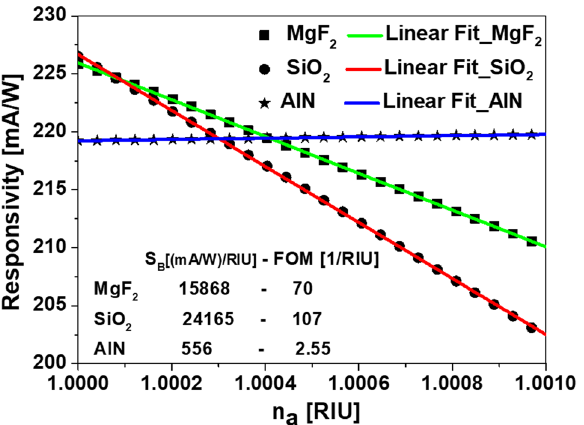
Figure 5. Responsivity, R , as a function of the refractive index of the analyte, n a , for the device with the optimized geometry of the bow-tie made of MgF 2 (black squares), SiO 2 (black circles), and AlN (black stars). The linear fitting of these simulated data are ploted in green for MgF 2 , red for SiO 2 , and line for AlN. The values of S B , and FOM are listed within the plot. The device is illuminated with a monochromatic light source, (cid:31) = 632.8